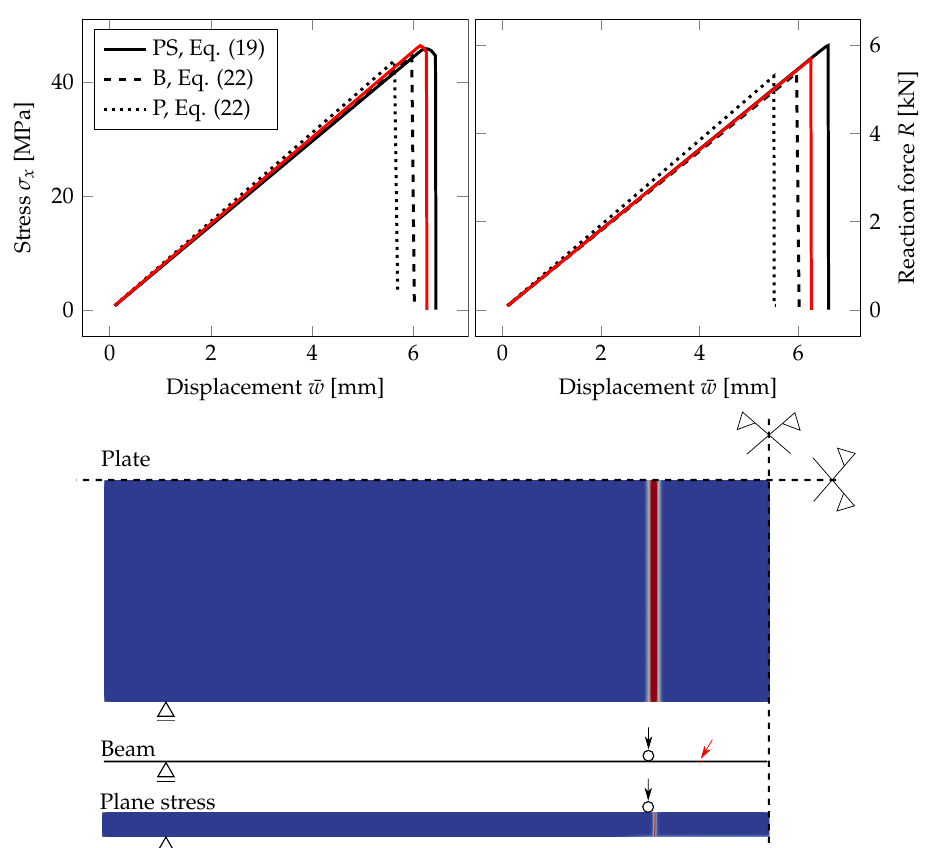
Figure 10. PF-P formulation, anisotropic staggered approach with the spectral-decomposition split: Comparison of plane stress (PS) for the PS-Refined mesh from Figure 4 (black line) or additionally refined in the area of the expected crack propagation (red line), beam (B), and plate (P) model in terms of the evolution of the largest tensile stress at the midpoint, the overall reaction, and the damage evolution showing the position of the localised